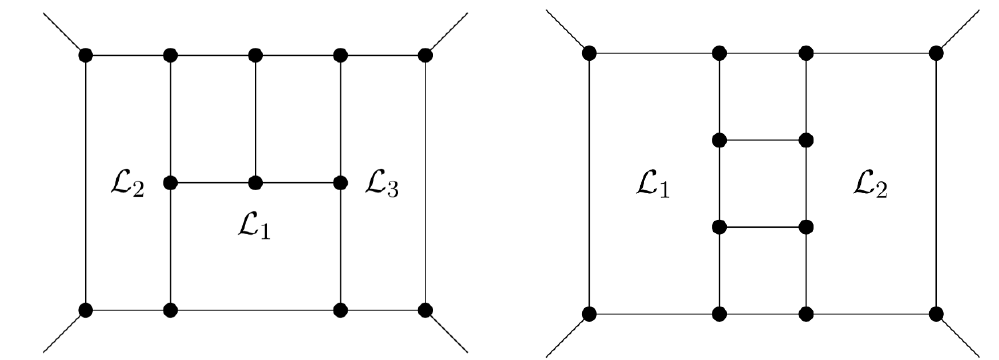
Figure 6 . The two local diagrams at (cid:12)ve loops which have the necessary number of internal propagators but nevertheless do not contribute to the (2 L (cid:0) 4)-dimensional cuts. Here we label the lines L (cid:11) = ( AB ) (cid:11)